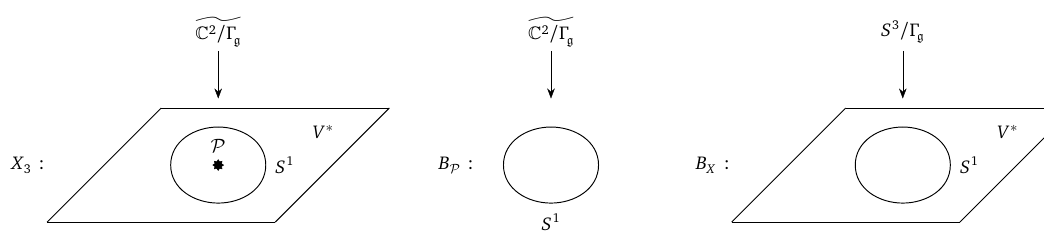
associated with a neigbourhood of the 3 = B ∪ B is given by ∂ X . P X 3 3